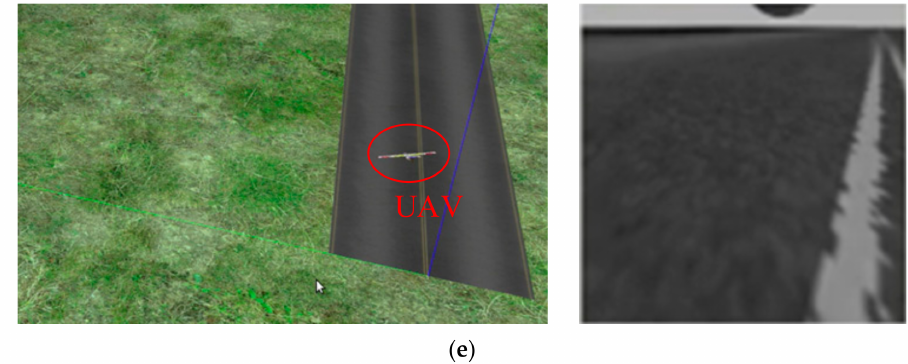
Figure 17. The landing process under case 3 ( a – e ). ( a ) t = 0.0 s; ( b ) t = 0.24 s; ( c ) t = 2.03 s; ( d ) t = 2.22 s; ( e ) t = 3.13 s.